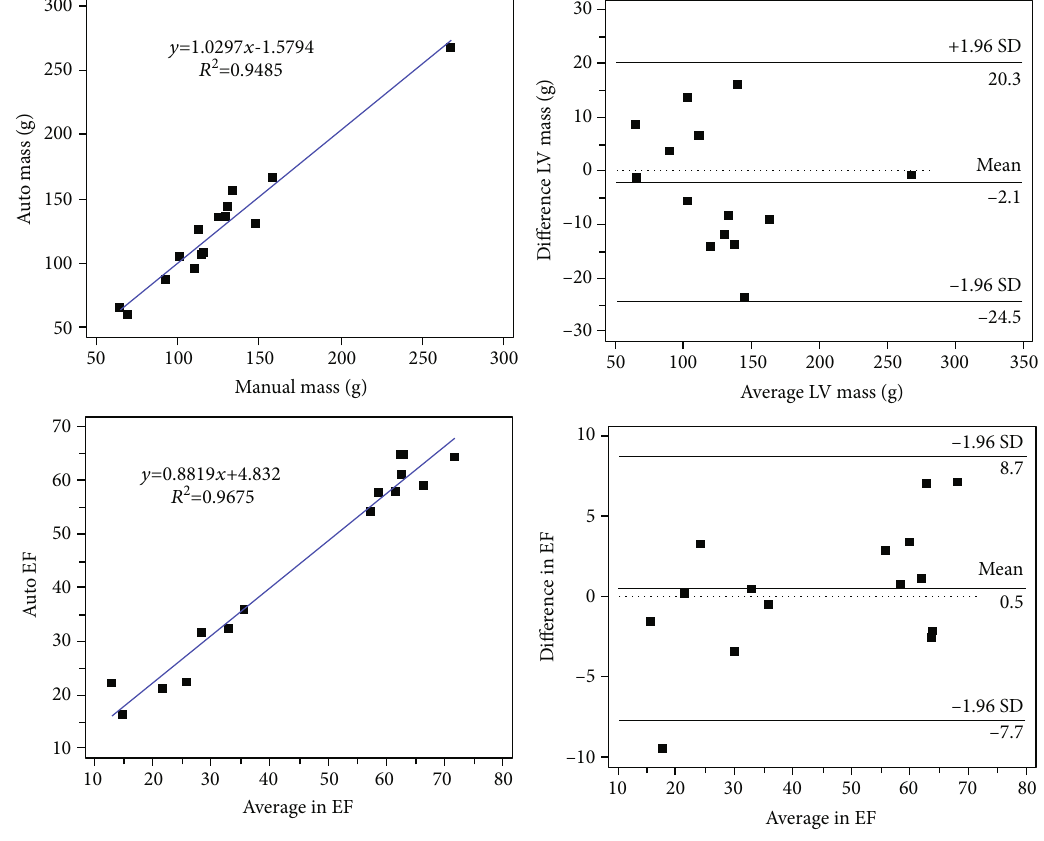
Figure 6: Regression and Bland-Altman plots for LVM and EF. The left side is the LVM and EF regression curves, and the right side is the Bland-Altman plots of LVM and